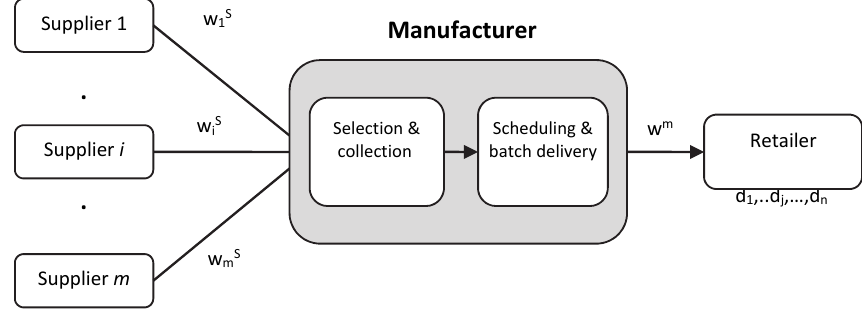
Fig. 1 . The decision context of the